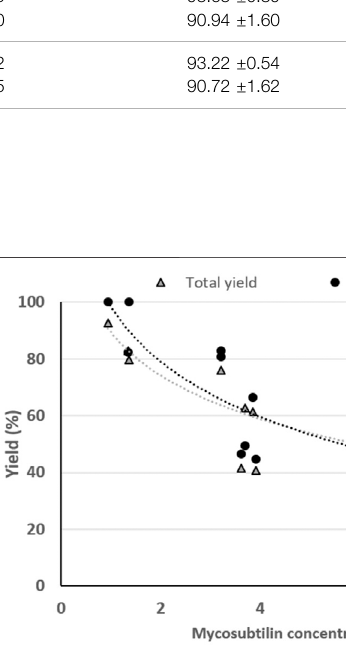
FIGURE 4 | Impact of the mycosubtilin concentration on the total yield and thelipopeptideyieldofthe spray-drying process. Gray triangle,total yield; black circle, lipopeptide yield. Each drying experiment was performed on distinct samples coming from different production